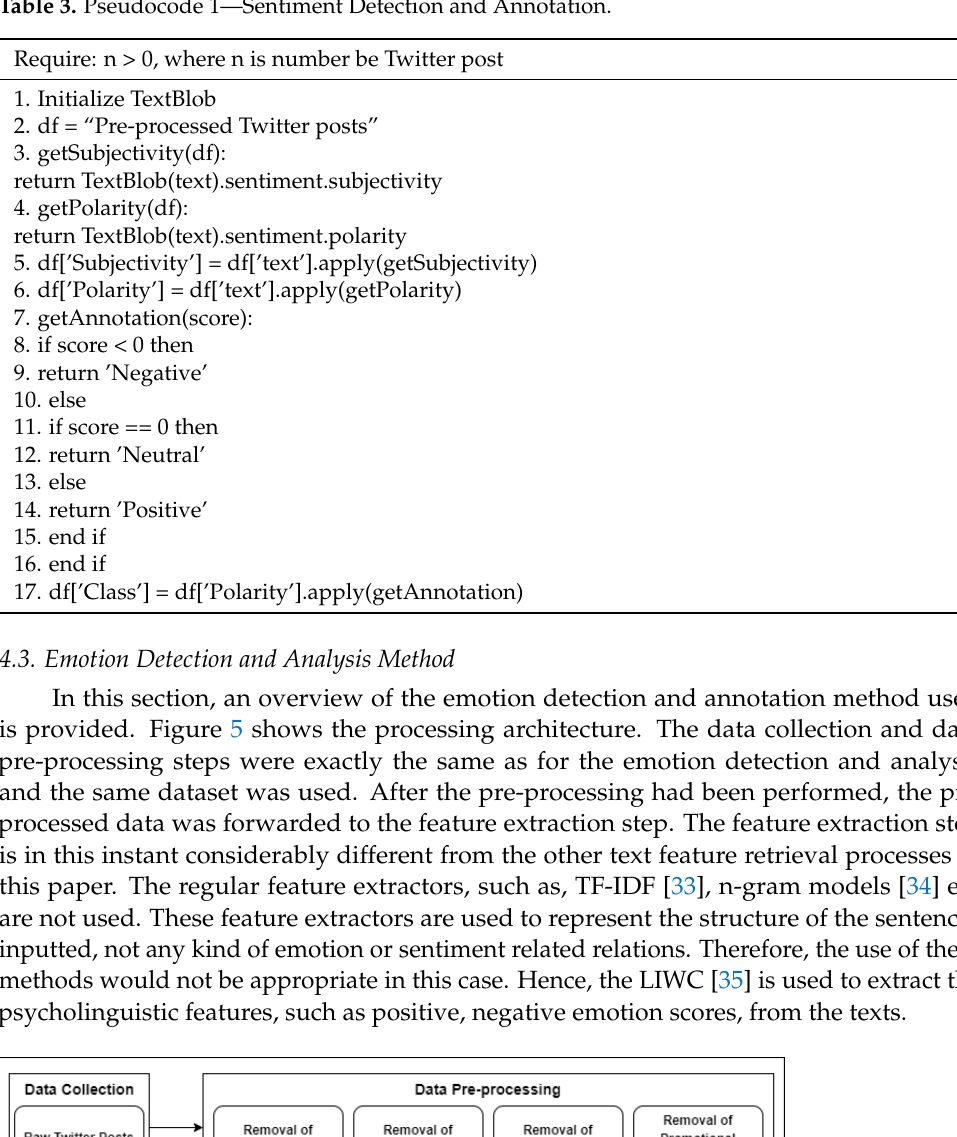
Table 3. Pseudocode 1—Sentiment Detection and Annotation.